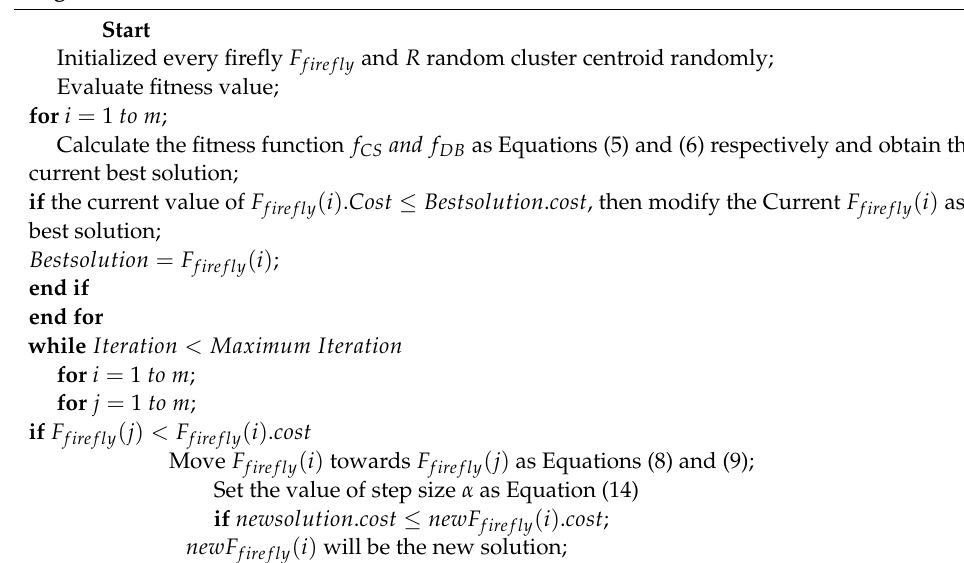
Algorithm 3. Pseudo code for